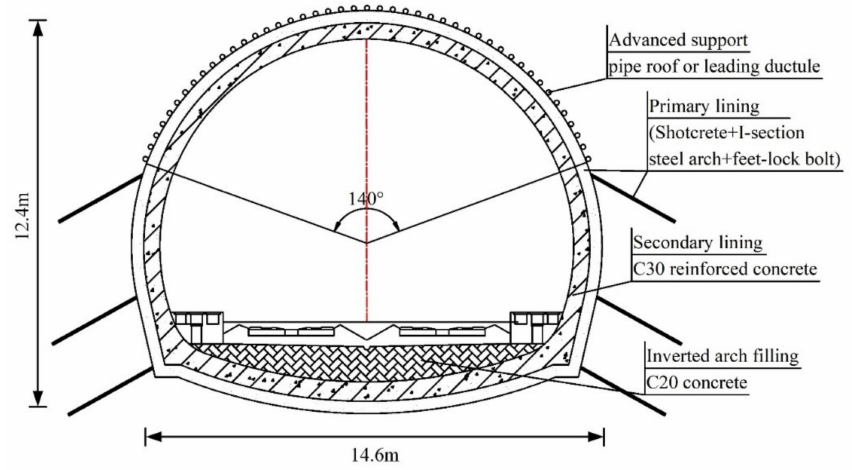
Figure 4. Support parameters of New Badaling